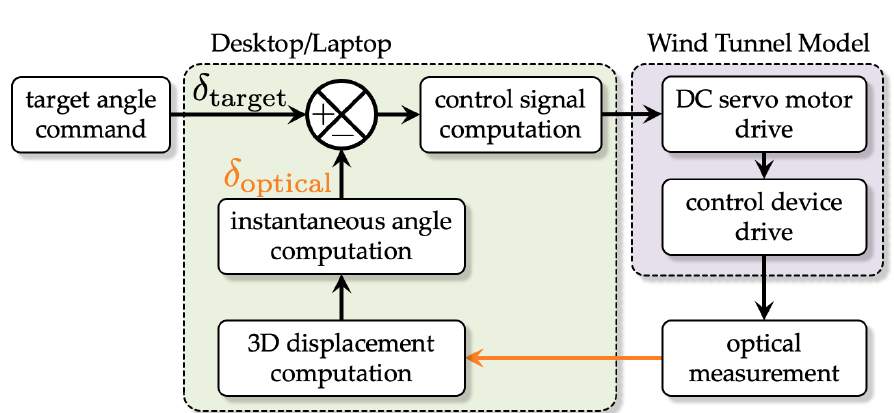
Figure 1. Block diagram of the control